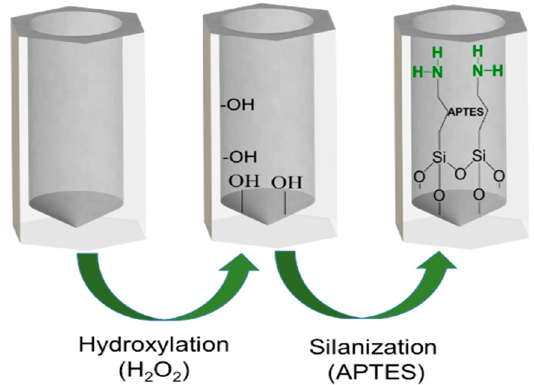
Figure 1. Schematics of the steps for the immobilization of APTES in NAA.